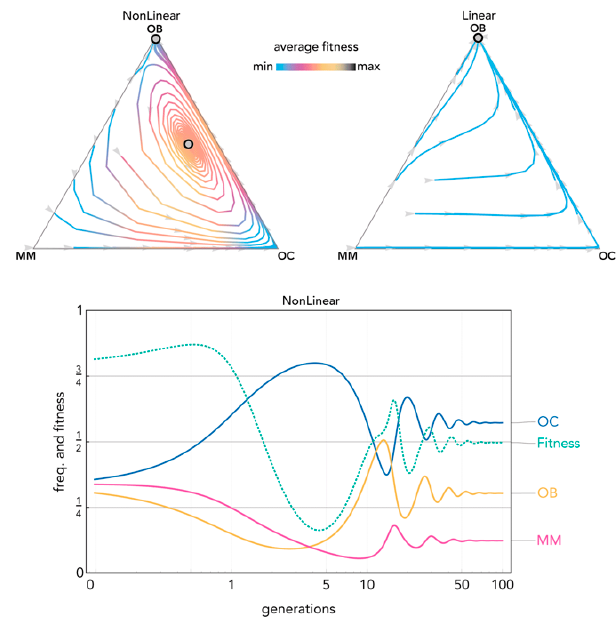
Figure 7. Nonlinear benefits can produce oscillations leading to an interior mixed equilibrium. The distance from each vertex is inversely proportional to the frequency of each type. Arrows show the direction of the dynamics; colors show the average fitness of the population. N = 10; c OC = 0.1; c OB = 0.12; c MM = 0.14; B OC,OC = 1; B OC,OB = 1; B OC,MM = 1; B OB,OC = 0.7; B OB,OB = 0.7; B OB,MM = 0.7; B MM,OC = 0.9; B MM,OB = 0.9; B MM,MM = 0.9; h OC,OC = 0.4; h OC,OB = 0.7; h OC,MM = 0.1; h OB,OC = 0.7; h OB,OB = 0.4; h OB,MM = 0.2; h MM,OC = 0.4, h MM,OB = 0.3; h MM,MM = 0.7. Nonlinear: s OC,OC = 20; s OC,OB = 20; s OC,MM = 5; s OB,OC = 10; s OB,OB = 10; s OB,MM = 50; s MM,OC = 10; s MM,OB = 5; s MM,MM = 5; Linear: s i,j → 0.